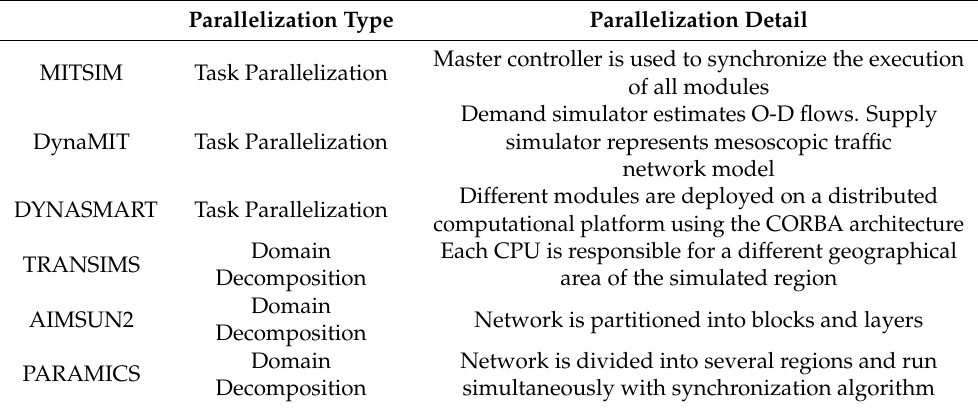
Table 2. Parallel and distributed computing in traffic